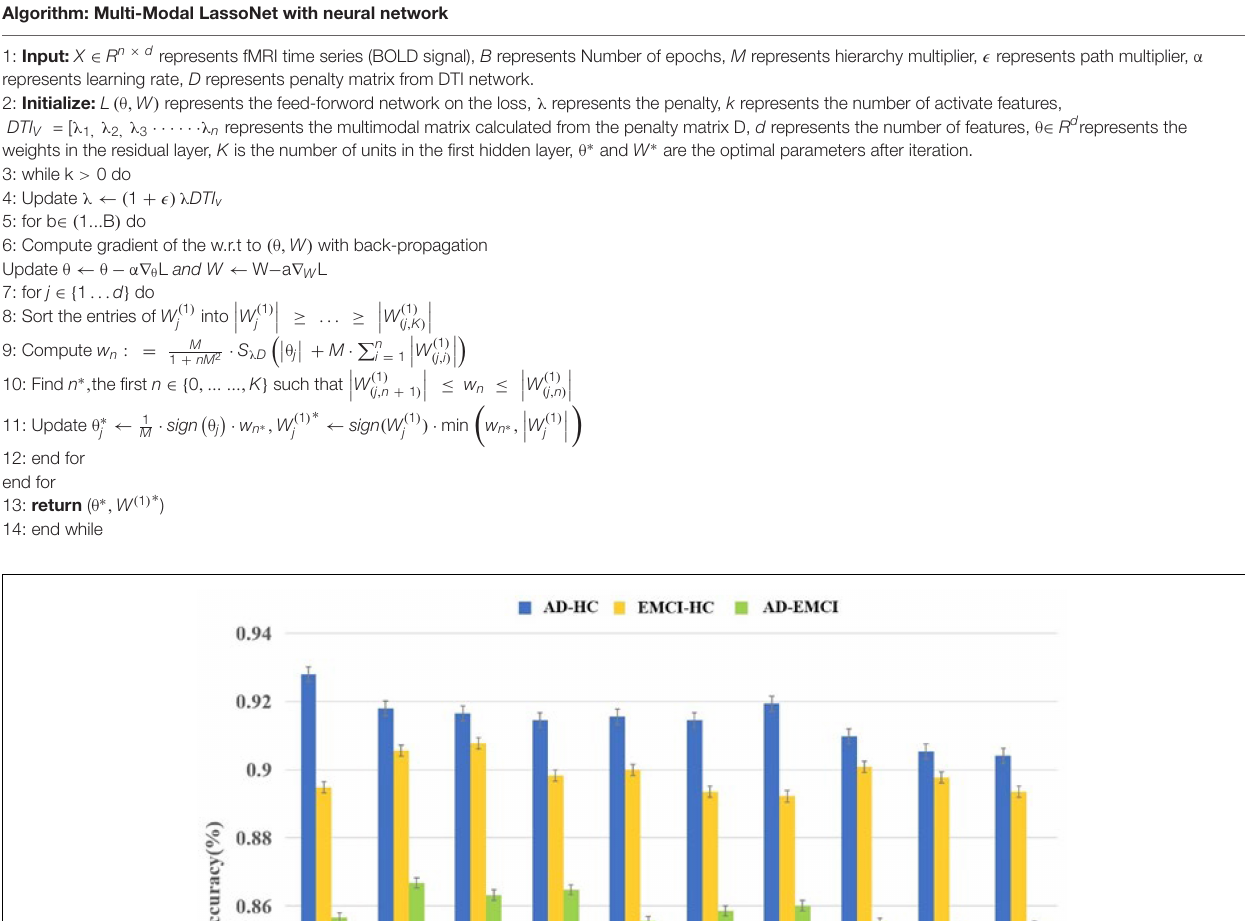
TABLE 2 | Training algorithm of multi-modal LassoNet. Algorithm: Multi-Modal LassoNet with neural network